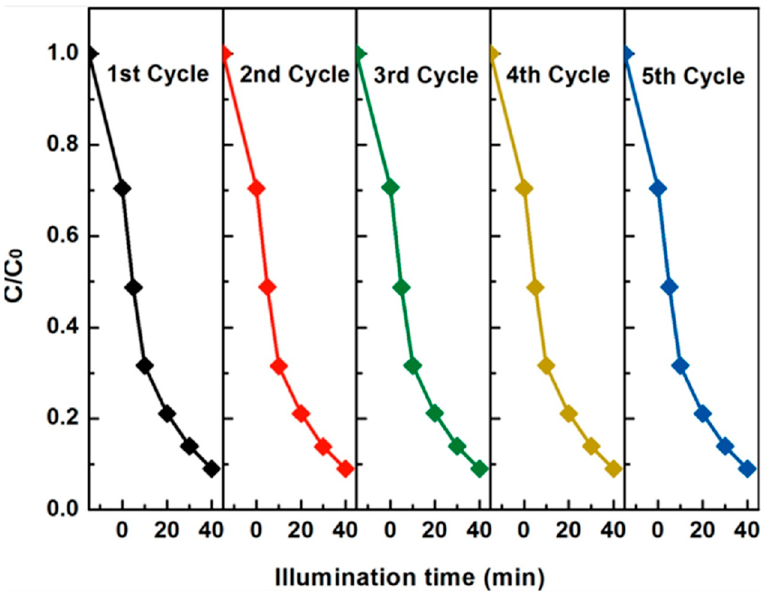
Figure 8. Photocatalytic stability of g-C 3 N 4 /GO aerogel in MO degradation over five cycle runs (a different color has been used to represent the lines related to different cycles). Reprinted with permission from [102] . Copyright © 2017 Elsevier.